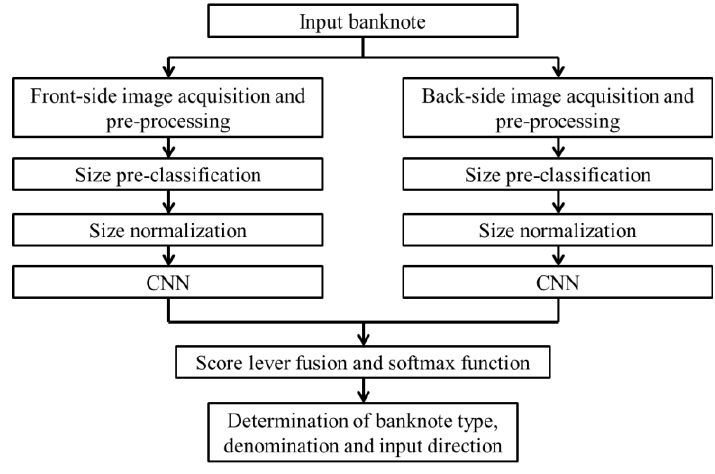
Figure 1. Overall flowchart of the proposed method.